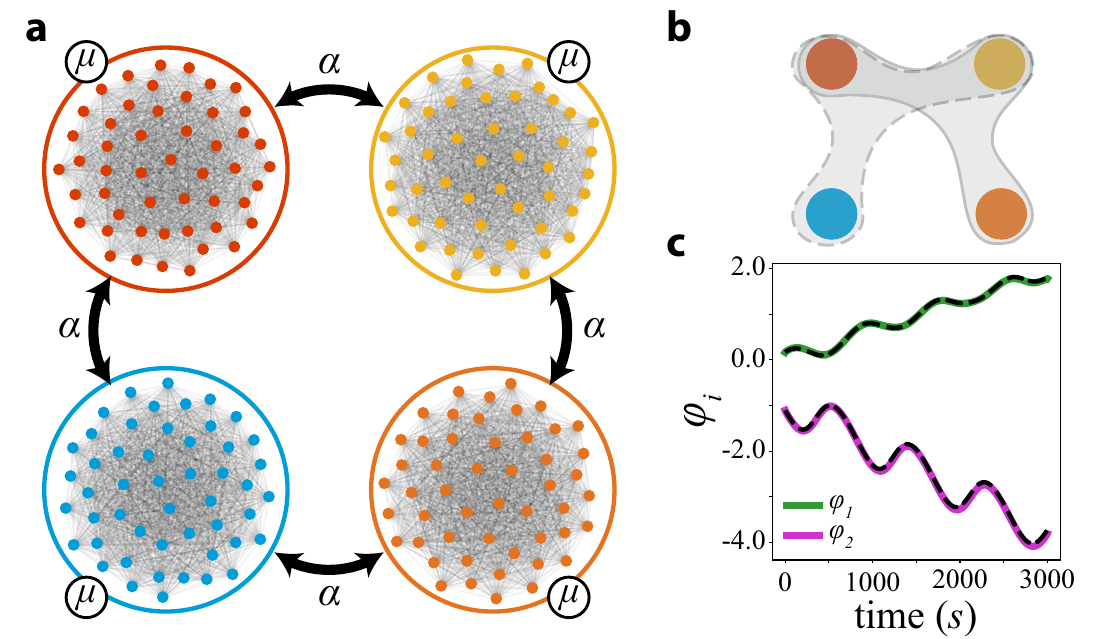
Fig. 4 | Interacting subpopulations lead to higher order interaction of mean- fi elds. a The original network of coupled subpopulations (with four distinct col- ours, namely, red, yellow, blue and orange). Oscillators are interacting by an internal coupling constant μ and inter-subpopulations coupling constant α . b Higher order phase interaction of the mean- fi elds represented with the same colors as in a (red, yellow, blue and orange). Applying our approach we uncover